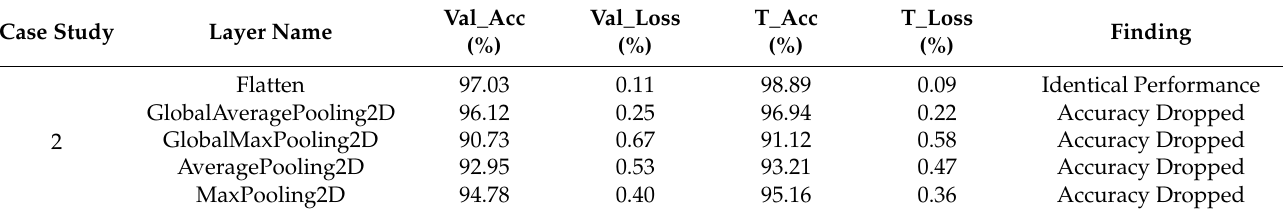
Table 7. Changing the Flatten layer to evaluate the ablation study.